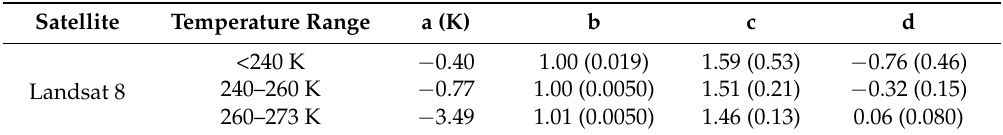
Table 1. Landsat 8 dual-band ice surface temperature retrieval coefficients and the standard errors of the coefficients (in parenthesis) in the Arctic as in Equation (1).